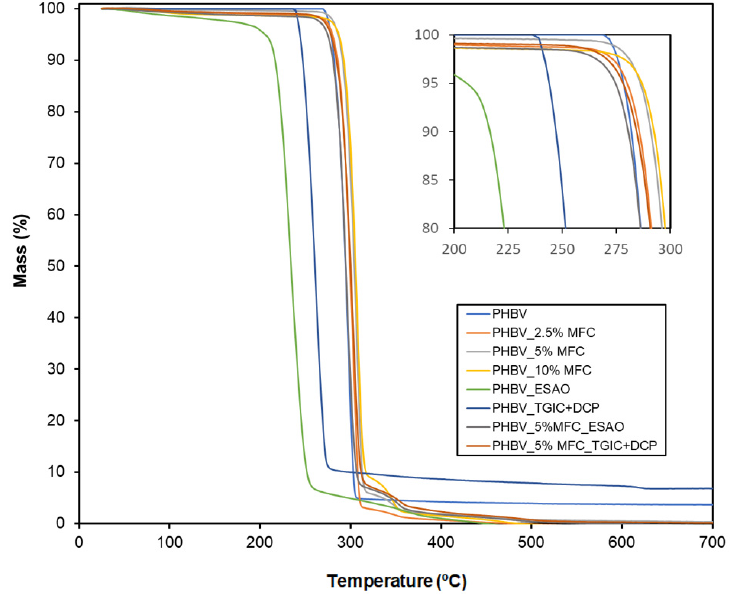
Figure 10. Thermogravimetric analysis (TGA) curves of the films of poly(3-hydroxybutyrate- co -3- hydroxyvalerate) (PHBV) with microfibrillated cellulose (MFC) and compatibilized with epoxy- based styrene-acrylic oligomer (ESAO) and with triglycidyl isocyanurate (TGIC) and dicumyl per- oxide (DCP).